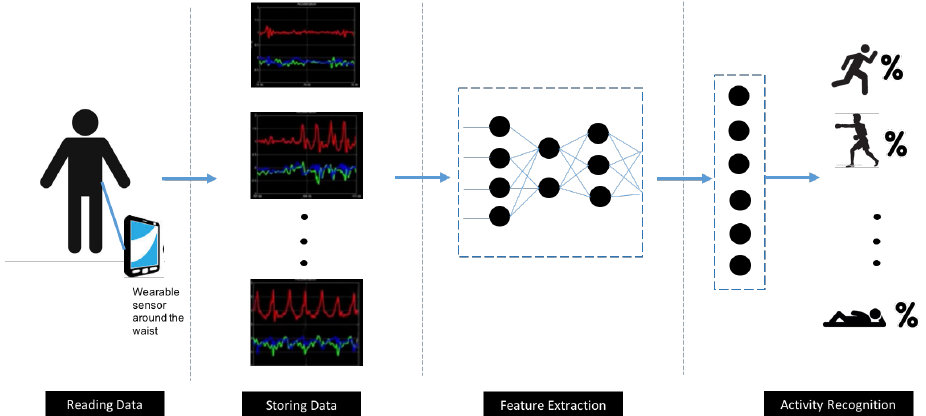
Figure 1. A block diagram of sensor-based human activity recognition using deep